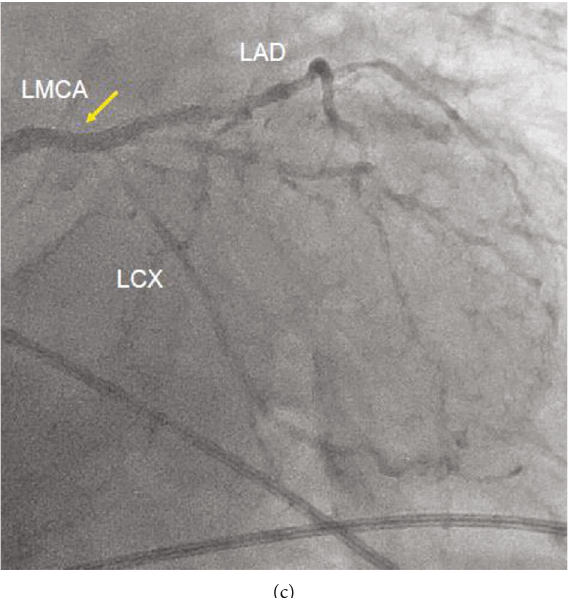
Figure 2: (a) Emergent coronary angiography. Right anterior oblique caudal view showing a severe stenosis of mid LMCA (arrow). LMCA: left main coronary artery; LAD: left anterior descending artery; LCX: left circum fl ex artery. (b) Intravascular ultrasound study. The section at the white line showing low attenuation plaque around the entire circumference of the vessel with ulceration (arrows) in the mid LMCA. LMCA: left main coronary artery; LAD: left anterior descending artery; LCX: left circum fl ex artery. (c) Final coronary angiography. Right anterior oblique caudal view showing no signi fi cant LMCA stenosis with grade 3 TIMI fl ow after stent implantation (arrow). LMCA: left main coronary artery; LAD: left anterior descending artery; LCX: left circum fl ex artery.